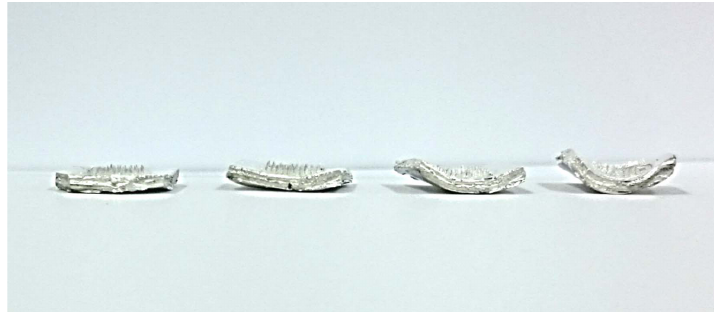
Figure 6. Various MNA electrodes having different